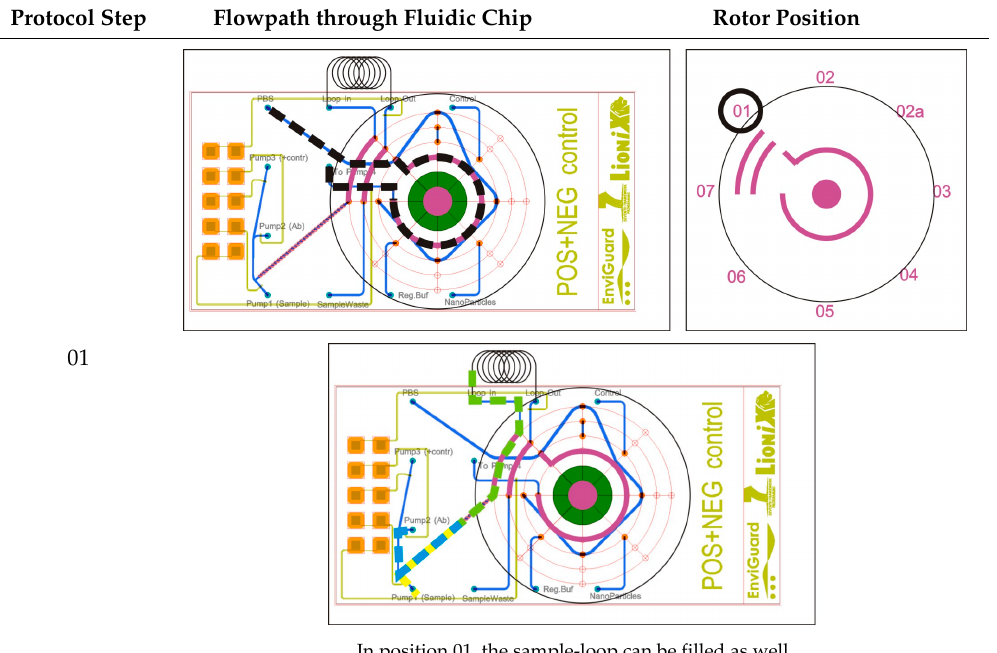
Figure A2. ( A ) Photograph of the valve’s fluidic chip. ( B ) Rotor.